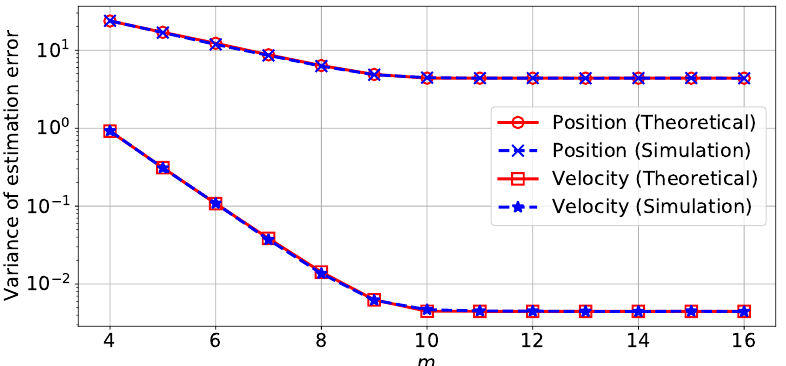
Figure 1. Theoretical and simulated variance of estimation error on the position and velocity depend- ing on the numbers of bits in the representation, using a reliable